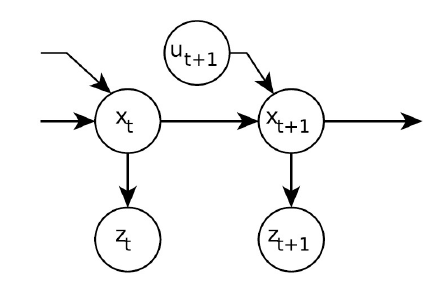
Figure 1. Graphical probabilistic model describing the Bayes filter. Each node describes a random variable. x j describes the vehicle’s state at time j , z j describes a measurement and u j a control state. Note that due to readability, we skipped the vector arrow in the